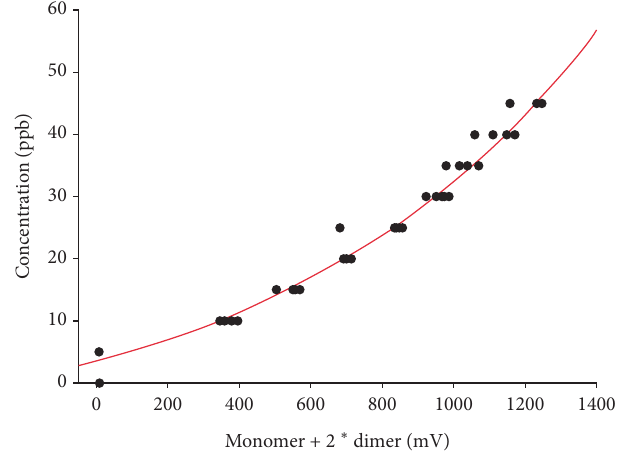
Figure 1: Calibration curve of acetone concentration (ppb acetone monomer and 2 ∗ acetone dimer (mV); R 2 � 0.98. Acetone concentration (ppb v ) � -10.3+13.8 ∗ exp (1.1 ∗ total acetone in- tensity (V)).